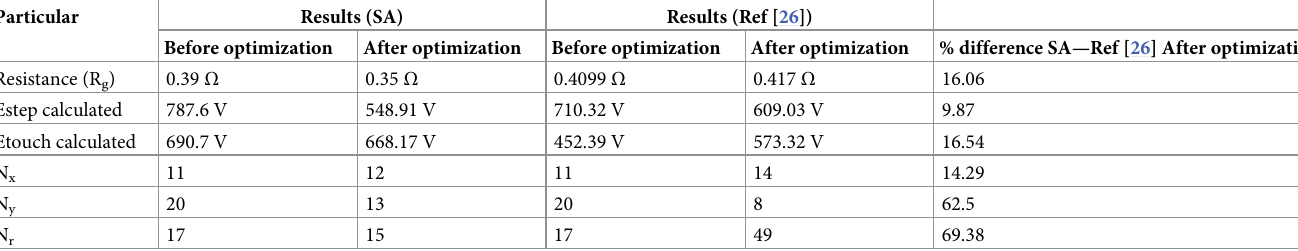
Table 13. Results for grounding system in uniform